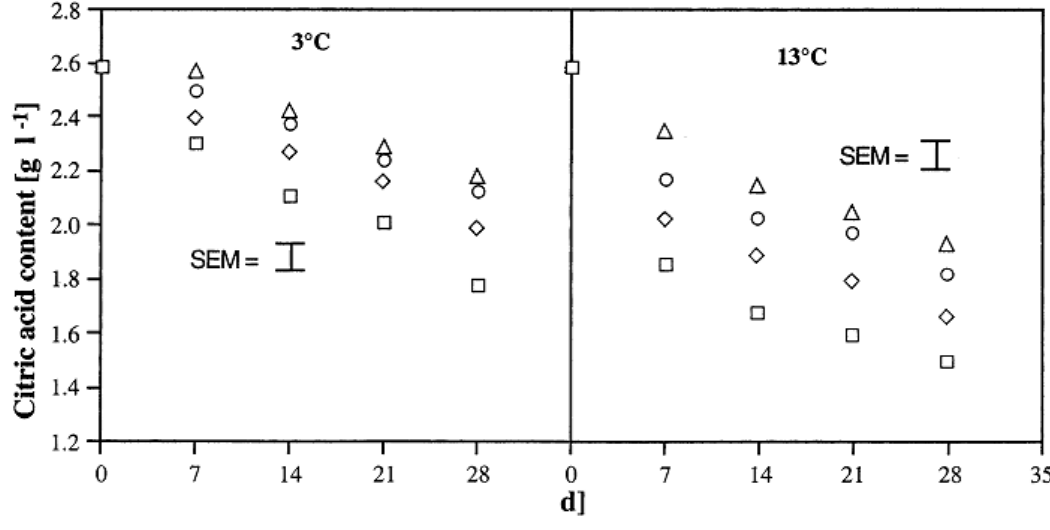
Figure 4. Effect of pre-harvest chitosan spray treatments on titratable acidity of strawberry fruit stored at 3 (S.E.M. ± 0.038) and 13 °C (S.E.M. ± 0.18); Control (□); 2 gl −1 (cid:28)( ◇ ); 4 gl −1 (○) and 6 gl −1 ( △ ). Data were pooled across the number of sprays and picks and repetitions. Reproduced from Reference